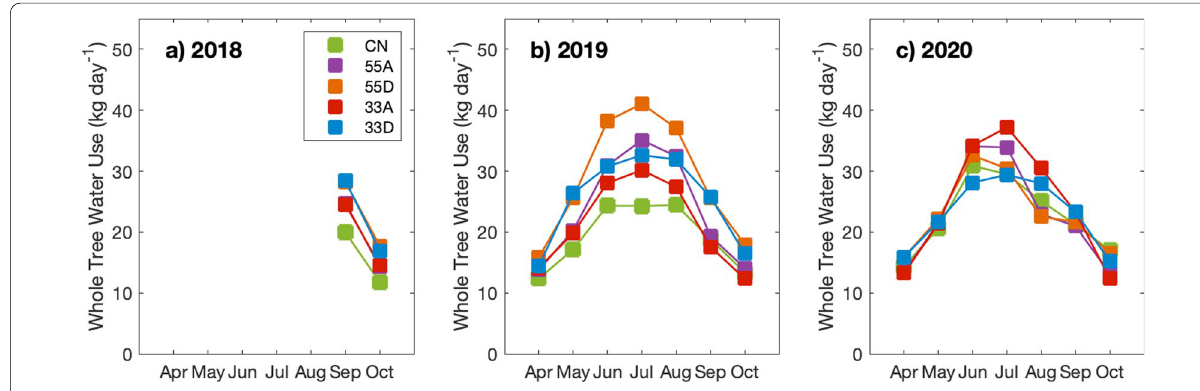
Fig. 4 Average daily whole-tree water use by month for 2018 ( a ), 2019 ( b ) and 2020 ( c